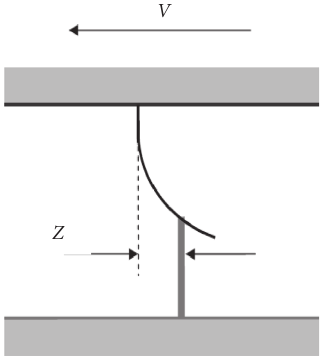
Figure 5: Deflected bristle in LuGre friction